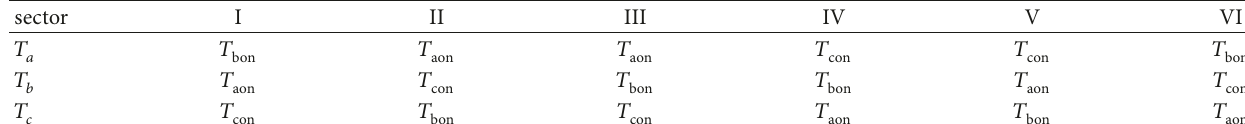
Table 6: The relationship between the vector switching point and its corresponding sector.